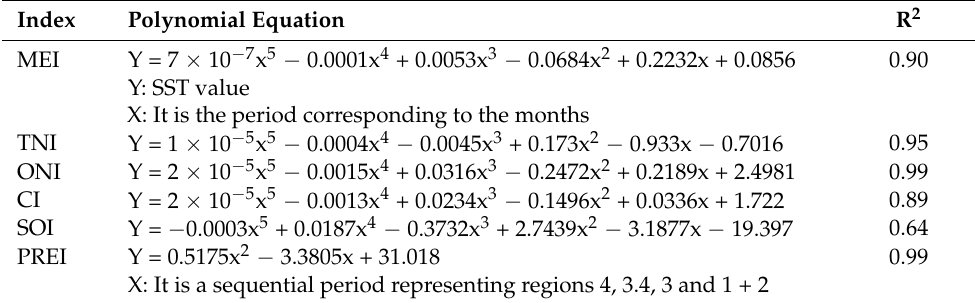
Table 1. Polynomial equations and R 2 values for each analyzed index.